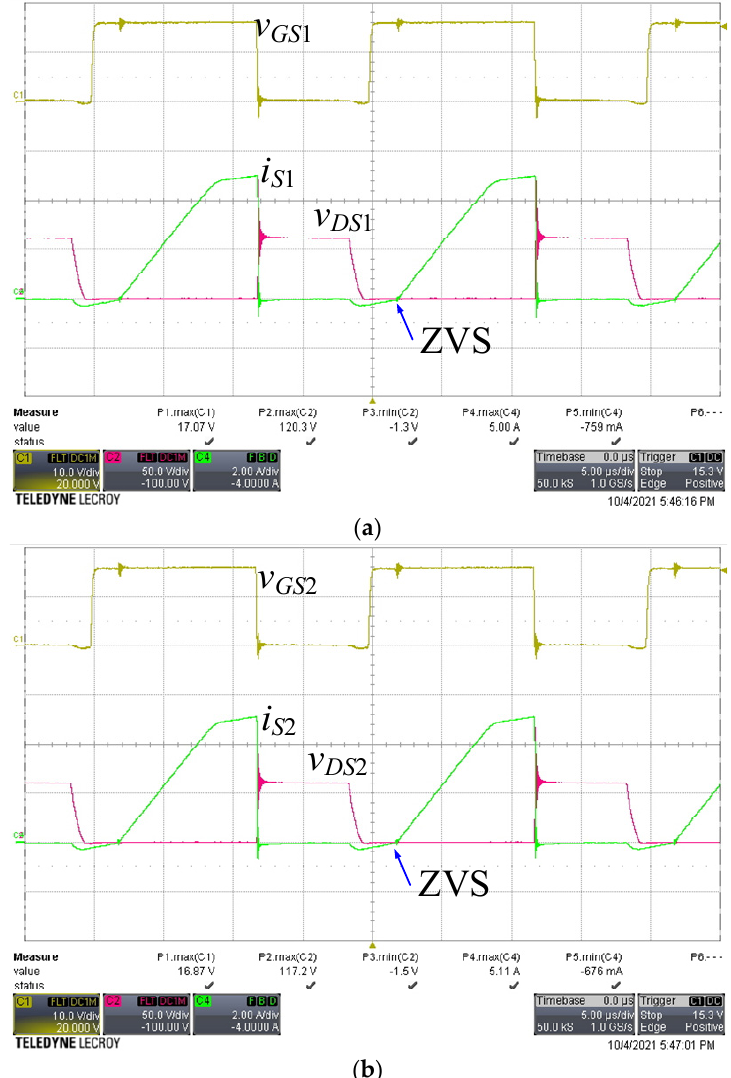
Figure 8. Voltage and current waveforms of the active switches. ( a ) v GS 1 , v DS 1 , and i S 1 ; ( b ) v GS 2 , v DS 2, and i S 2 ( v GS 1 , v GS 2 : 10 V/div, v DS 1 , v DS 2 : 50 V/div, i S 1 , i S 2 : 2 A/div, time: 5 μ s/div).